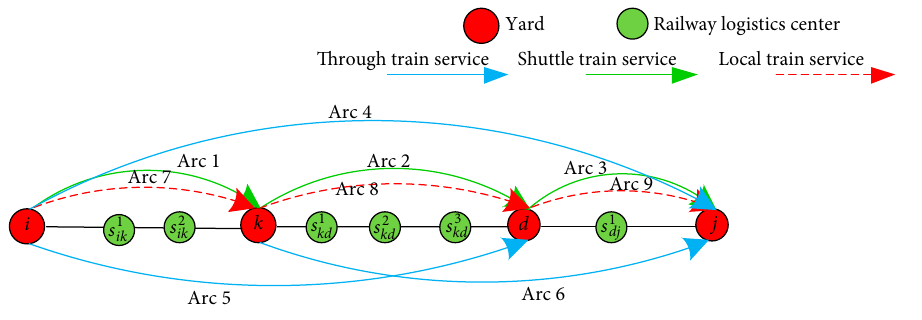
Figure 1: A railway service